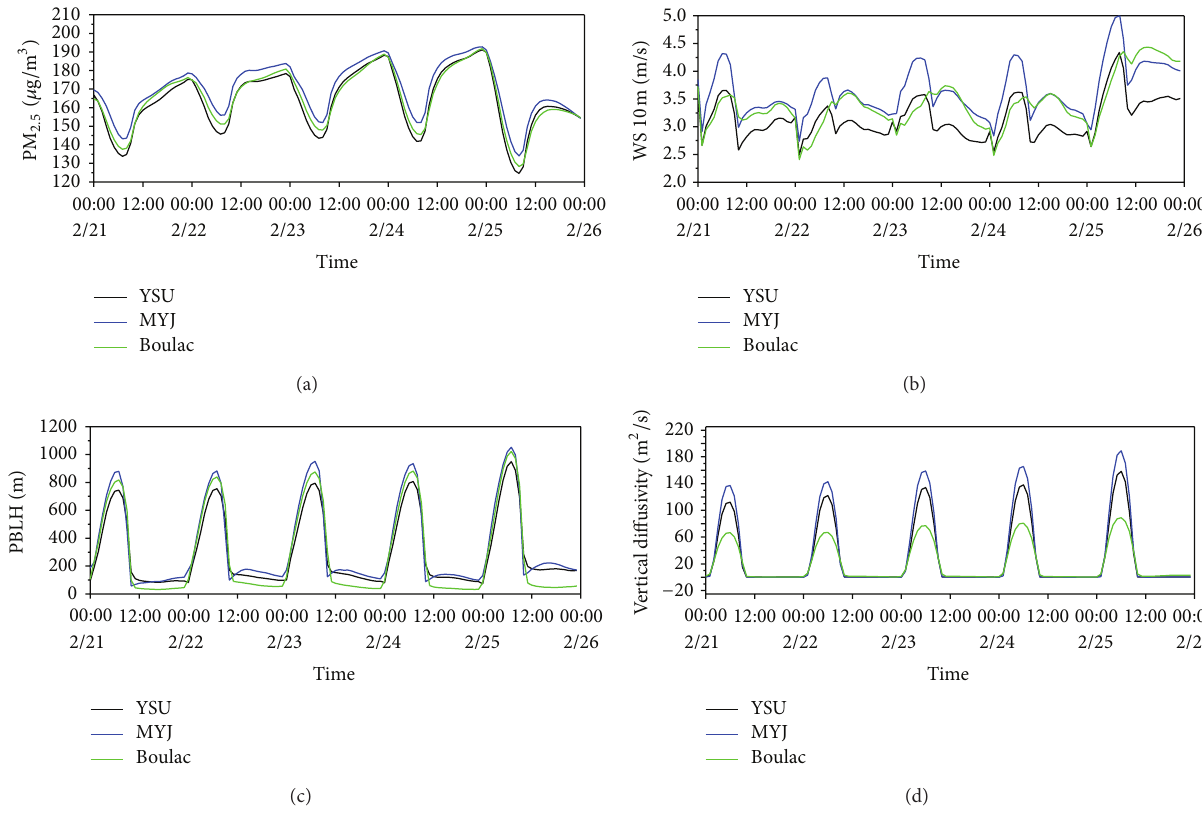
Figure 6: Hourly variations of the area-averaged PM 2.5 concentration (a), wind speed at 10 m (b), PBLH (c), and vertical diffusivity (d) during the haze